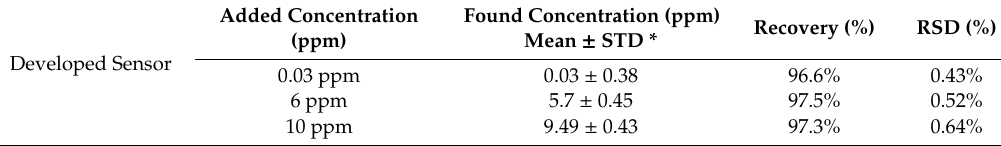
Table 4. Recovery study of the developed